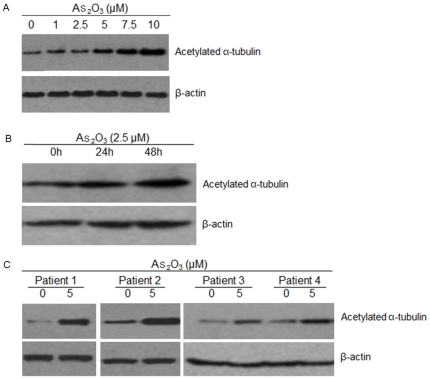
As2O3 triggers the accumulation of α-tubulin acetylation.(A) NCI-H929 cells were cultured with As2O3 (1 µM, 2.5 µM, 5 µM, 7.5 µM and 10 µM) for 48 hours. (B) NCI-H929 cells were cultured with As2O3 (2.5 µM) for the indicated time periods. (C) Primary tumor cells from MM patients were cultured with As2O3 (5 µM) for 12 hours.